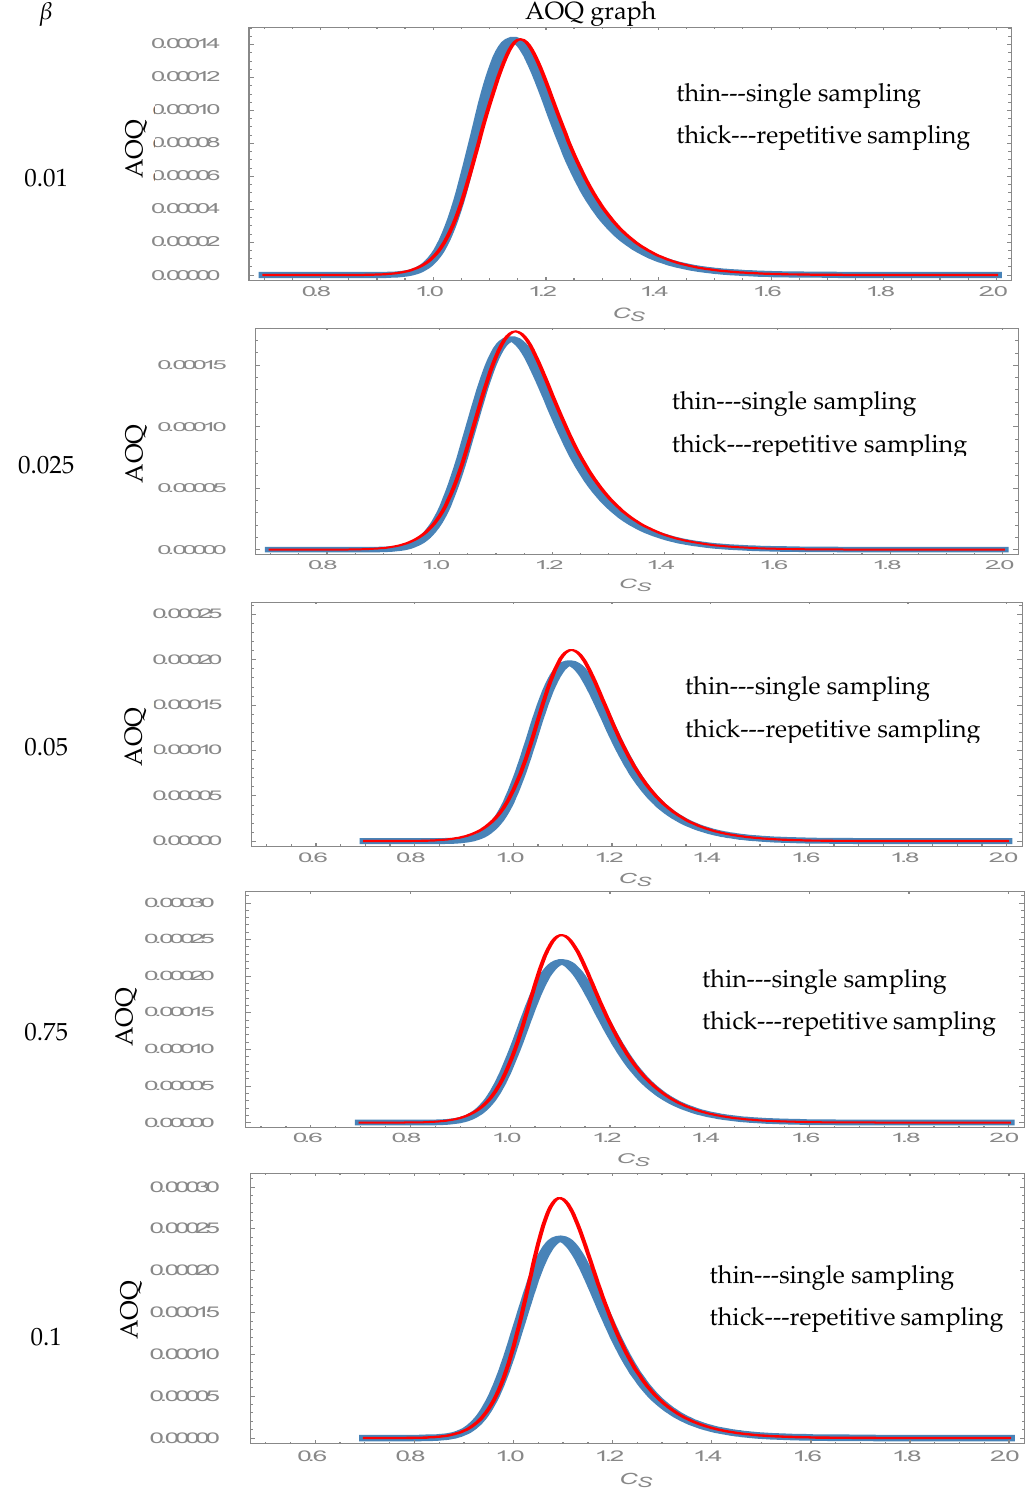
Figure 3. Graphs of average outgoing quality (AOQ) versus C s for the two rectifying sampling plans.